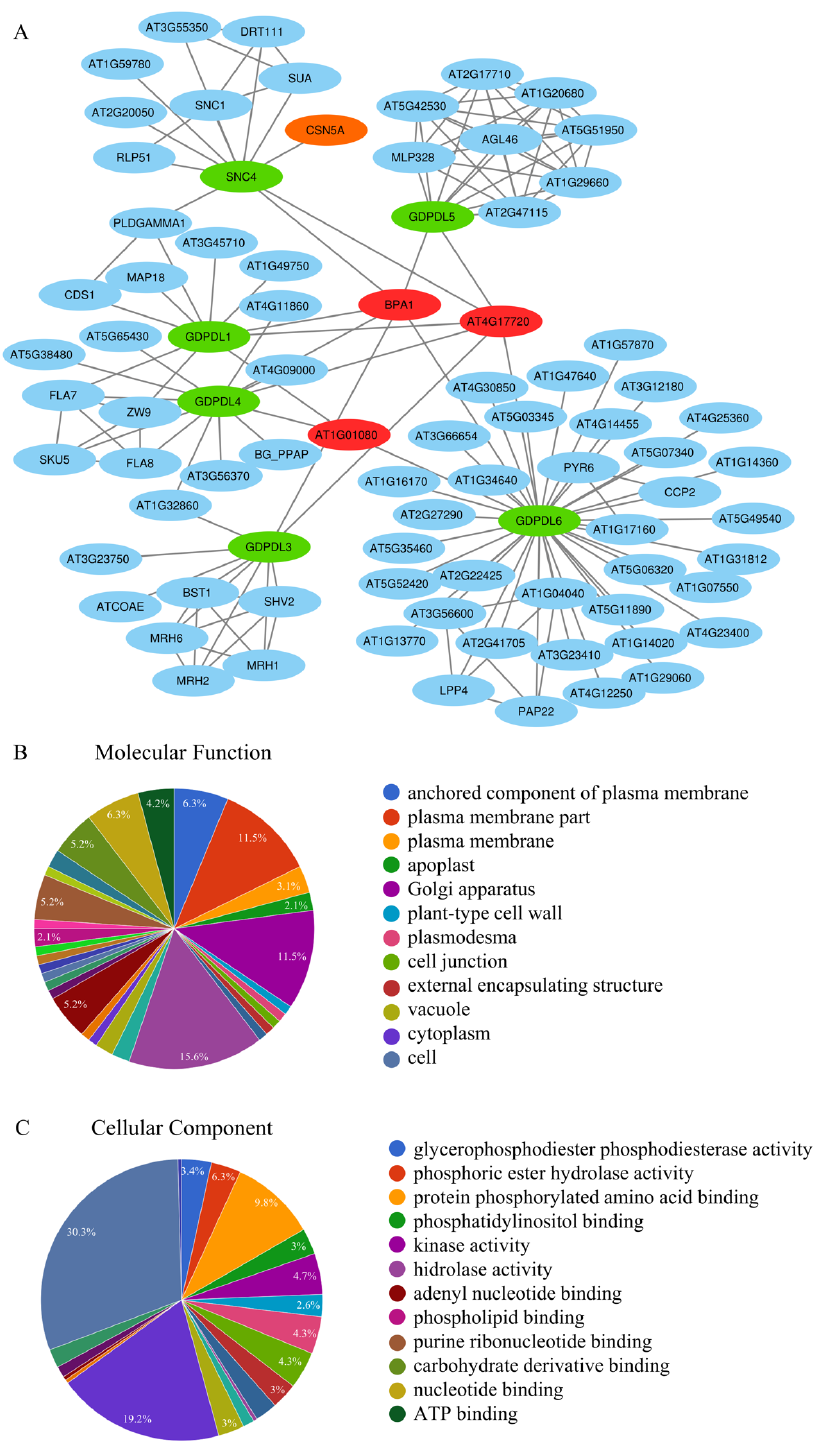
Figure 3. GDPDL-RLPs-interacting Arabidopsis proteins. ( A ) GDPDL-RLP-interacting proteins were identified in the Arabidopsis interactome, and the network was assembled by the Cytoscape software. GDPDL-RLPs and SNC4 (GDPDL2) are indicated in green, GDPDL-specifically interacting proteins in light blue, RNA-binding proteins, which interact with all 6 GDPDLs, including GDPDL_RLK (SNC4), are shown in red. In orange, CSN5A as a central hub of plant-pathogen interactions ( B ) Gene enrichment of proteins under the molecular function term from the GDPD-RLP-Arabidopsis protein- protein interactions (PPI) network. ( C ) Gene enrichment of proteins from the GDPD-RLP-Arabidopsis PPI network under the cellular component